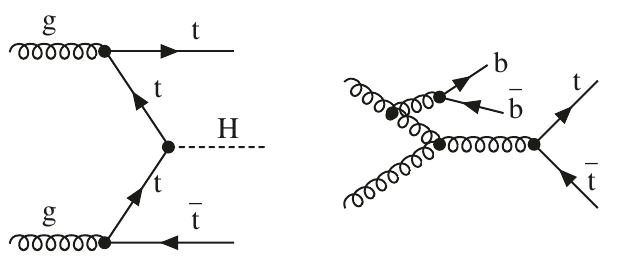
Figure 5 . Examples of LO Feynman diagrams for the partonic processes of gg and gg !